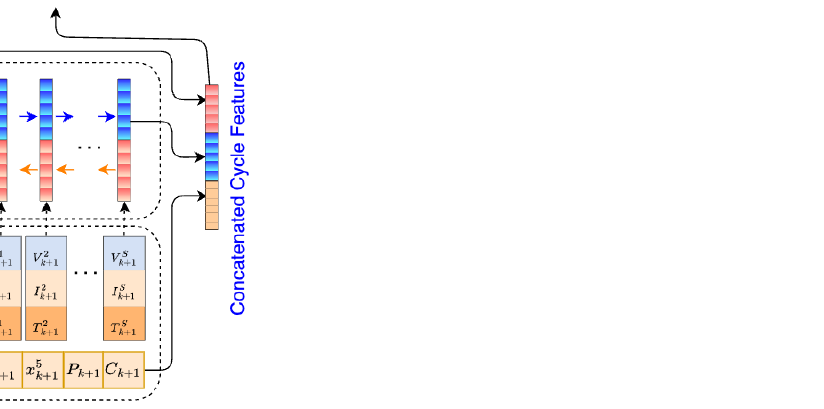
Figure 9. The concatenated cycle features encoded by the Bi-LSTM channel-wise